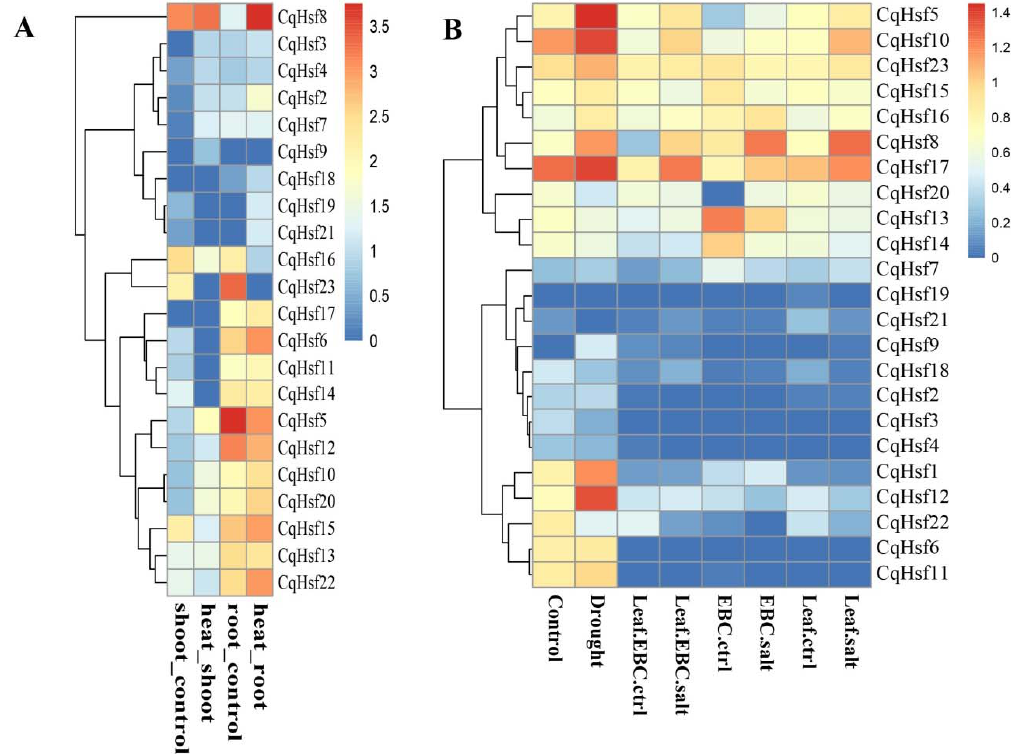
Figure 5. Expression patterns of CqHsf genes under heat stress ( A ) as well as under drought and salt stresses ( B ). Red bars represent high expression levels and blue bars represent low expression levels.